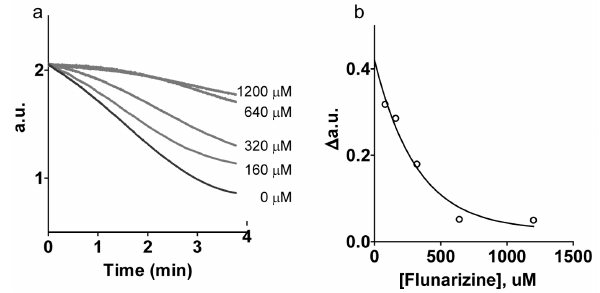
Figure 2. Inhibition of PyAeADHII at 70 6 C by flunarizine dihydrochloride. The assay was performed with 260 nM PyAeADHII in 50 mM NaPO4 pH 7.5, 3 mM a -tetralone, 0.3 mM NADPH in the presence of 80–1200 m M flunarizine dihydrochloride in DMSO/isopro- panol. a) Absorbance of NADPH (340 nm) was measured over time at different flunarizine concentrations. b) The rate of NADPH conversion ( D a.u. = absorbance unit change/minute) versus flunarizine concen- tration.